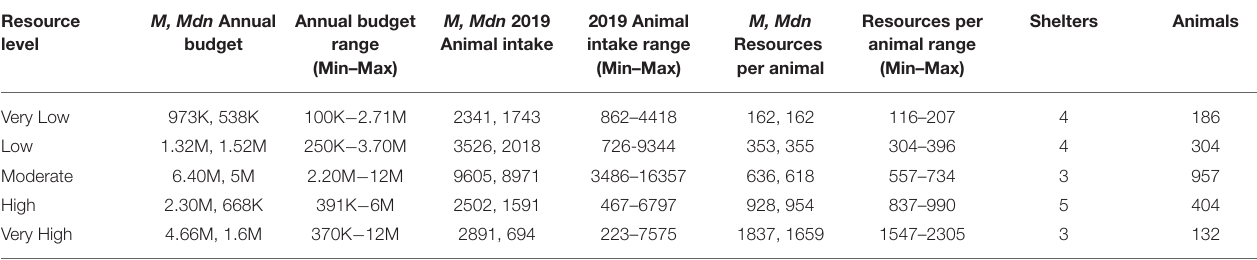
TABLE 3 | Shelter resource levels and associated annual budgets, animal intake numbers, and resources per animal. Resource